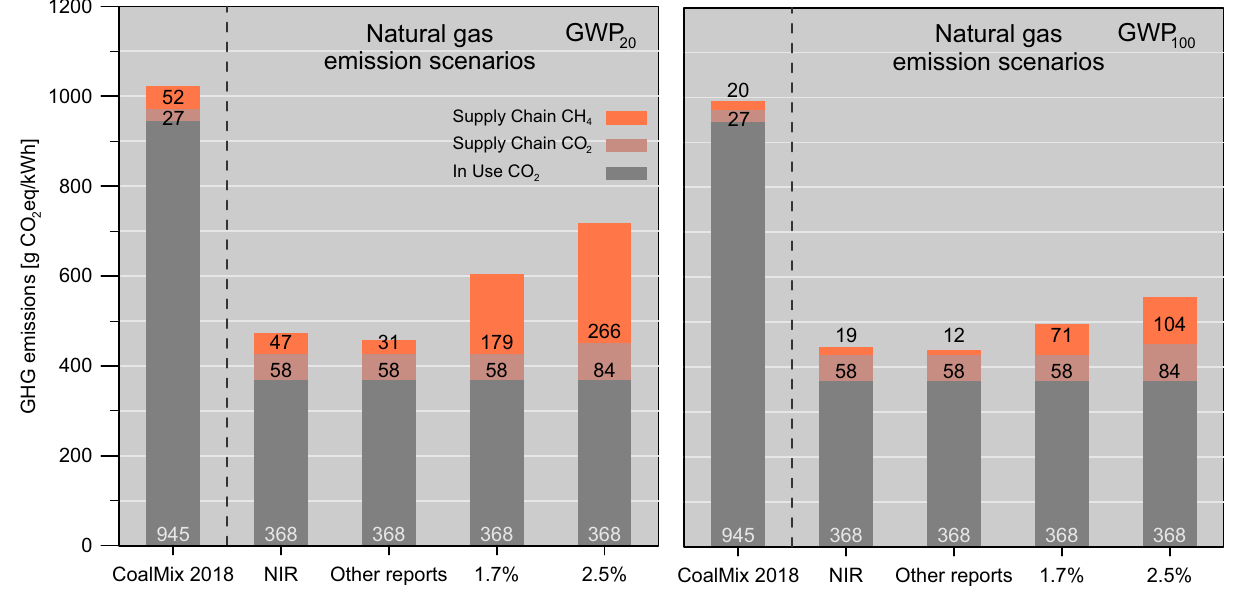
Figure 4. GHG emissions scenarios for Germany compared to 2018 coal mix emissions; left panel using GWP 20 , right GWP 100 . The “NIR scenario” with 0.45% methane leakage rate is based on National Inventory reports and the “Other reports scenario” with 0.32% methane leakage rate from import countries from life- cycle-analysis studies. For comparison, two additional scenarios are presented: a world-wide average “1.7% methane leakage rate scenario” based on IEA, and an upper bound “2.5% scenario”, including e.g. also higher supply-chain CO 2 emissions from long-distance pipeline or LNG